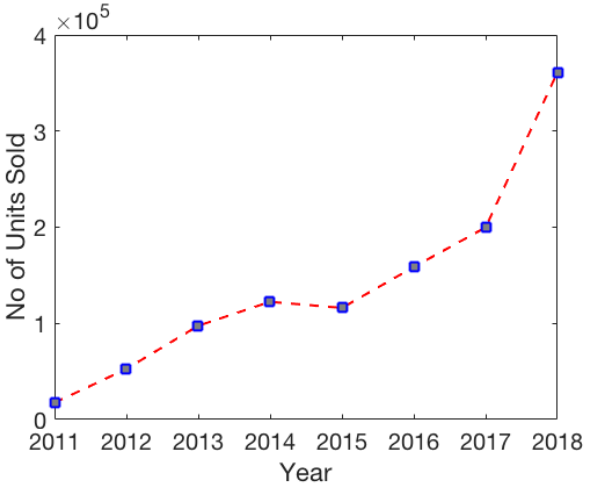
Figure 1. Electric vehicles sold in the US market — economic analysis for the units purchased.